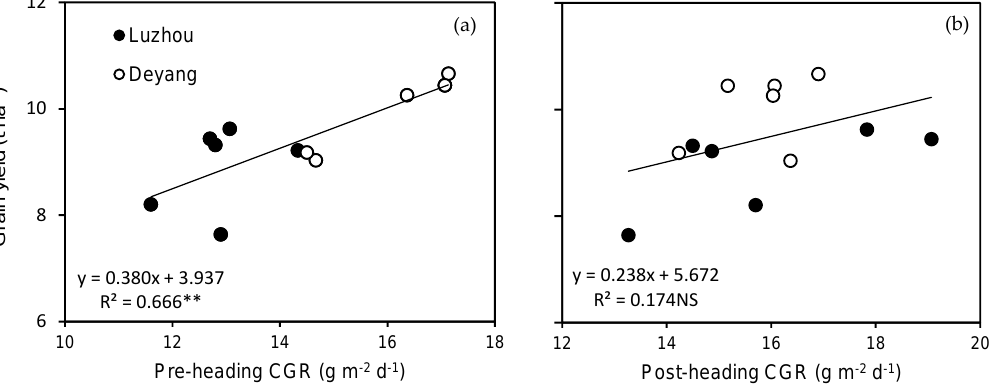
Figure 5. Relationships between grain yield and crop growth rate (CGR, g m − 2 d − 1 ) during the pre- and post-heading periods for six rice cultivars grown in two locations from 2018 to 2020. Data are